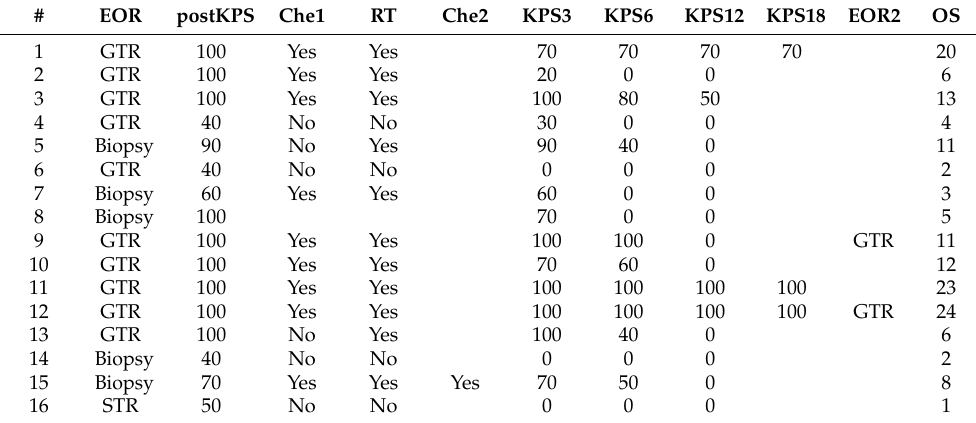
Table 2. Postoperative data . EOR: extent of resection; GTR: gross total resection; STR: subtotal resection; Che1: first-line adjuvant chemotherapy; RT: radiotherapy; Che2: second-line adjuvant chemotherapy; KPS3/6/12/18: 3, 6, 12, 18 months KPS; EOR2: second intervention extent of resection; OS: overall survival.